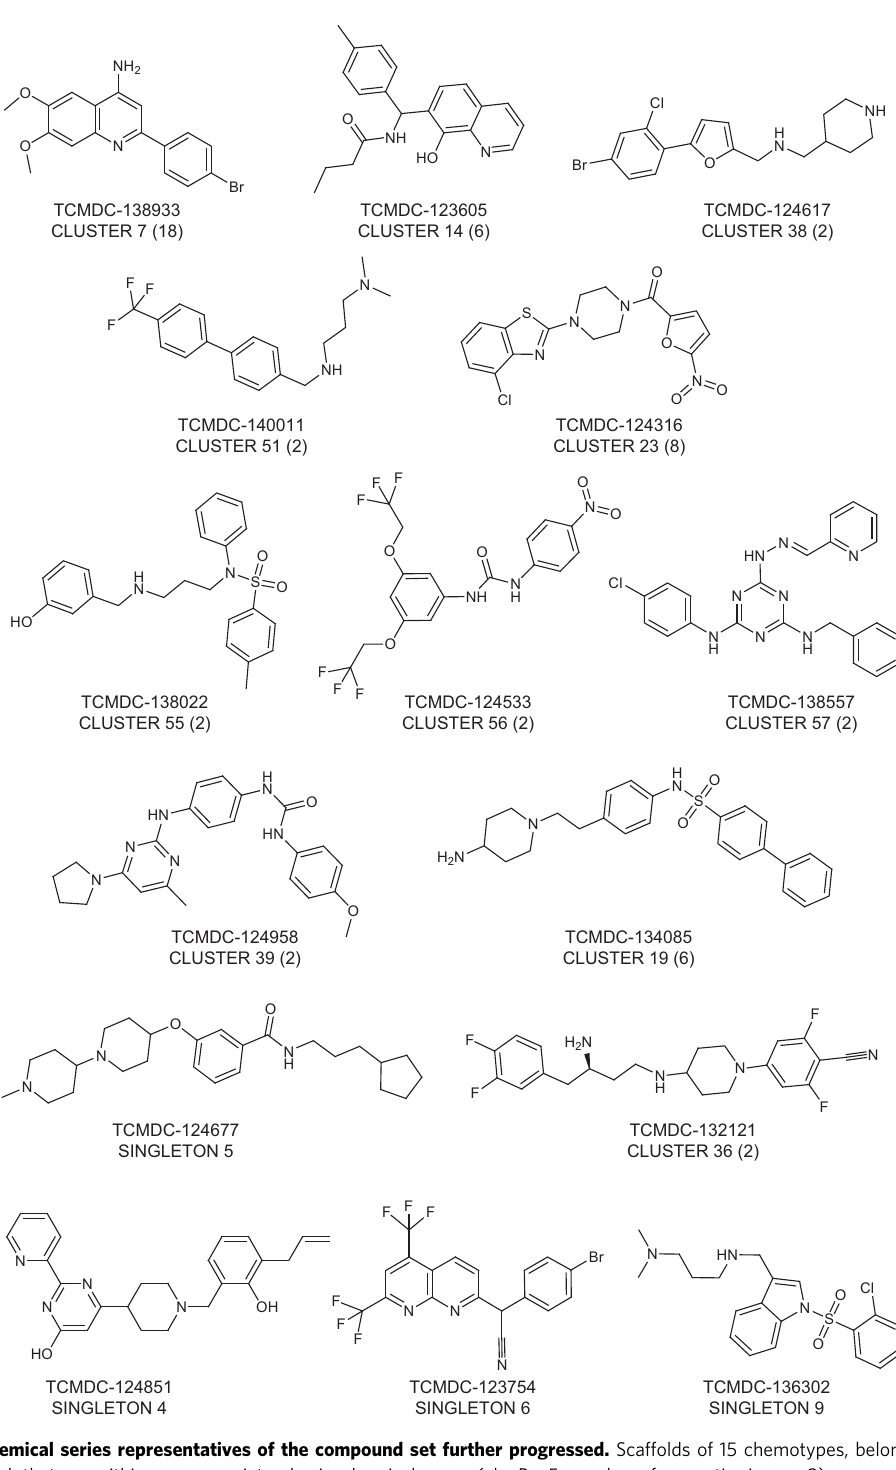
48 h incubation time (Table 1). Compounds were tested in duplicate in 2–3 independent experiments in the indirect format of the assay, that is, gametocytes were exposed to the drug for 48 h before mosquito feeding to replicate a drug exposure time equivalent to that used in the Pf FGAA. Five of these selected compounds showed a reduction in oocyst prevalence of 58–100% (Fig. 6a), and a reduction in oocyst intensity of 4 80% (Fig. 6b).